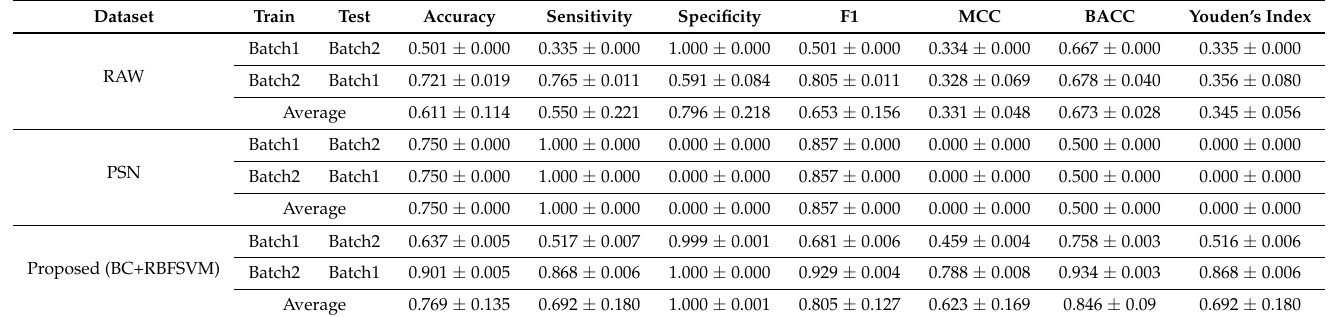
Table 2. Performance summary of the proposed